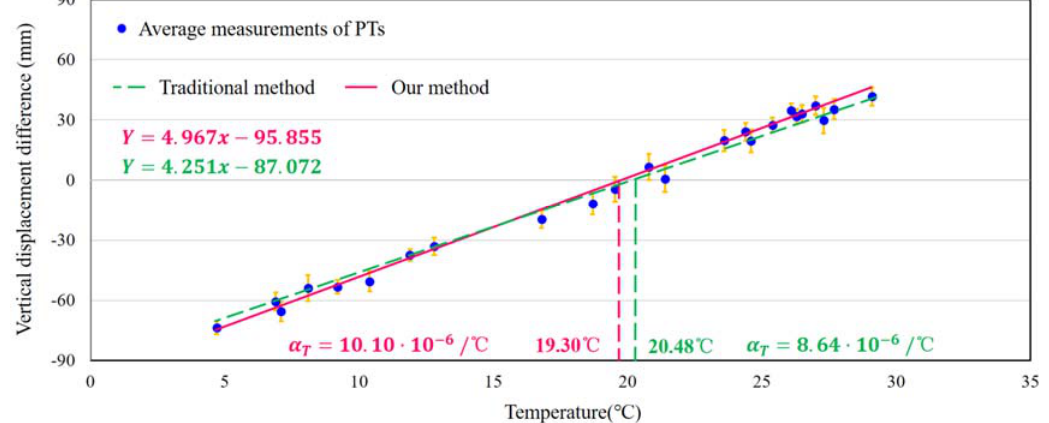
Figure 5. The time series vertical displacements of the SWFC.